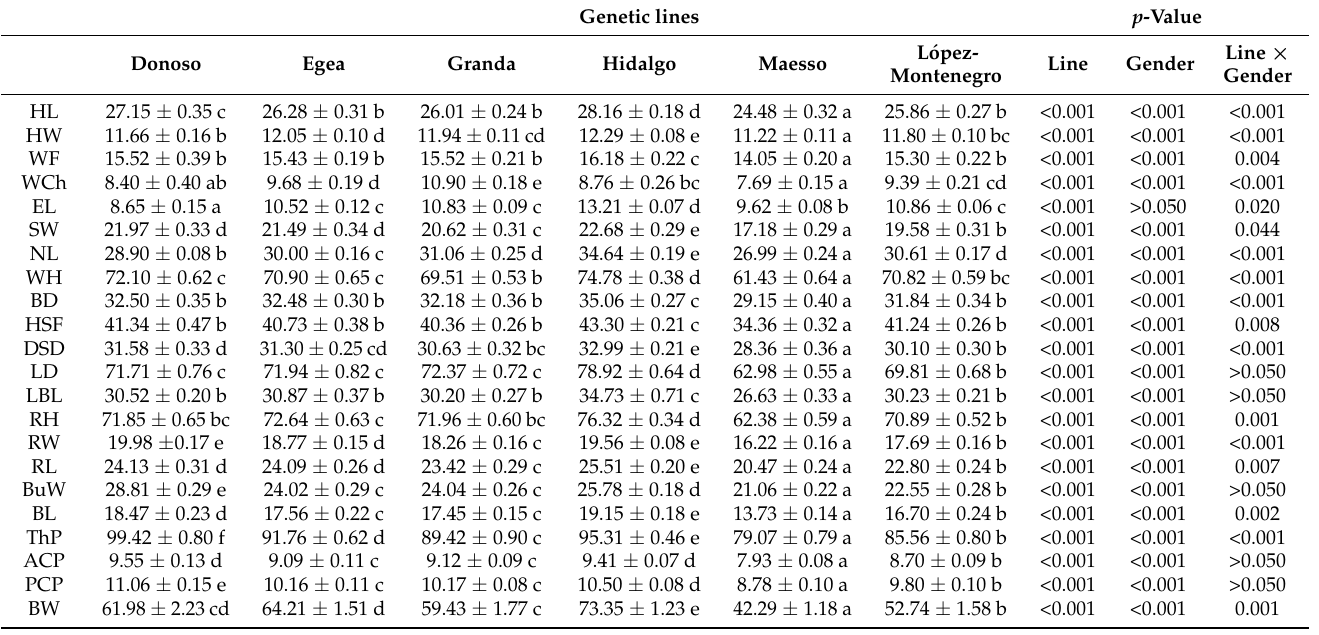
a–f.—Different superscripts in the same row indicate significant differences between genetic lines. Head length (HL), Head width (HW), Wool extension on forehead “bow” (WF), Wool extension on cheeks (WCh), Ear length (EL), Shoulder width (SW), Neck length (NL), Lumbar back line length (LBL), Rump width (RW), Rump length (RL), Buttock width (BuW), Buttock length (BL), Wither height (WH), Bicostal diameter (BD), Height at substernal foramen (HSF), Dorso-sternal diameter (DSL), Longitudinal diameter (LD), Rump height (RH), Thoracic perimeter (TP), Anterior and posterior cannon bone perimeter (ACP and PCP), and Body weight